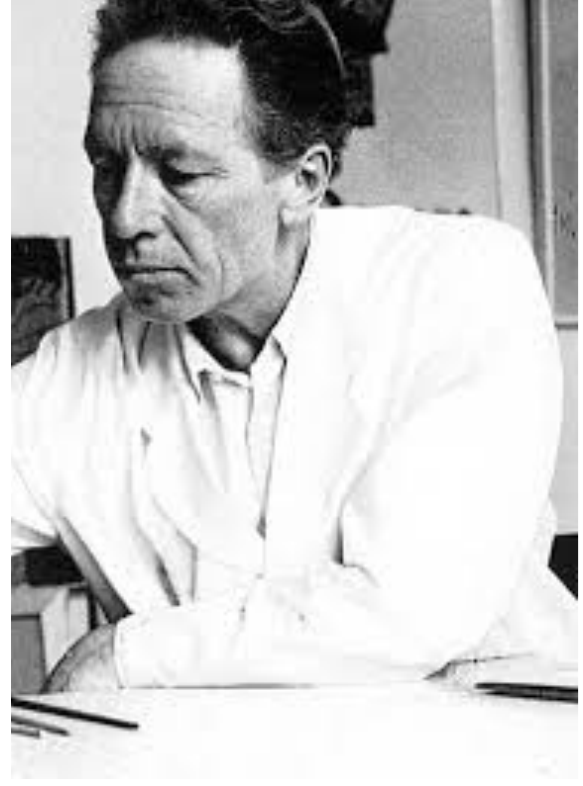
Figure 4 | Heinz Trökes